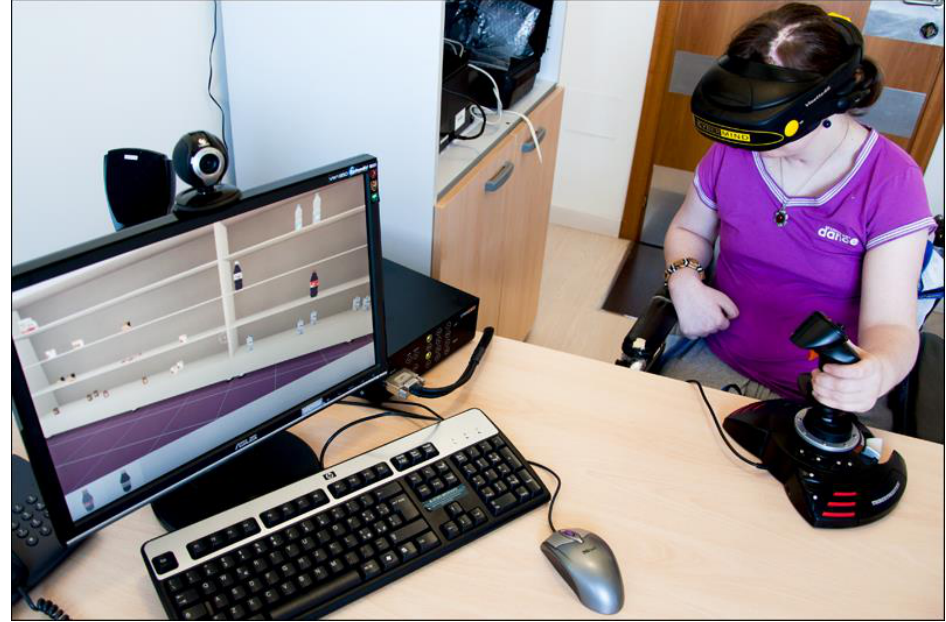
Figure 1. Virtual Reality application on a neurological patient in a rehabilitation setting at Institute S’Anna.